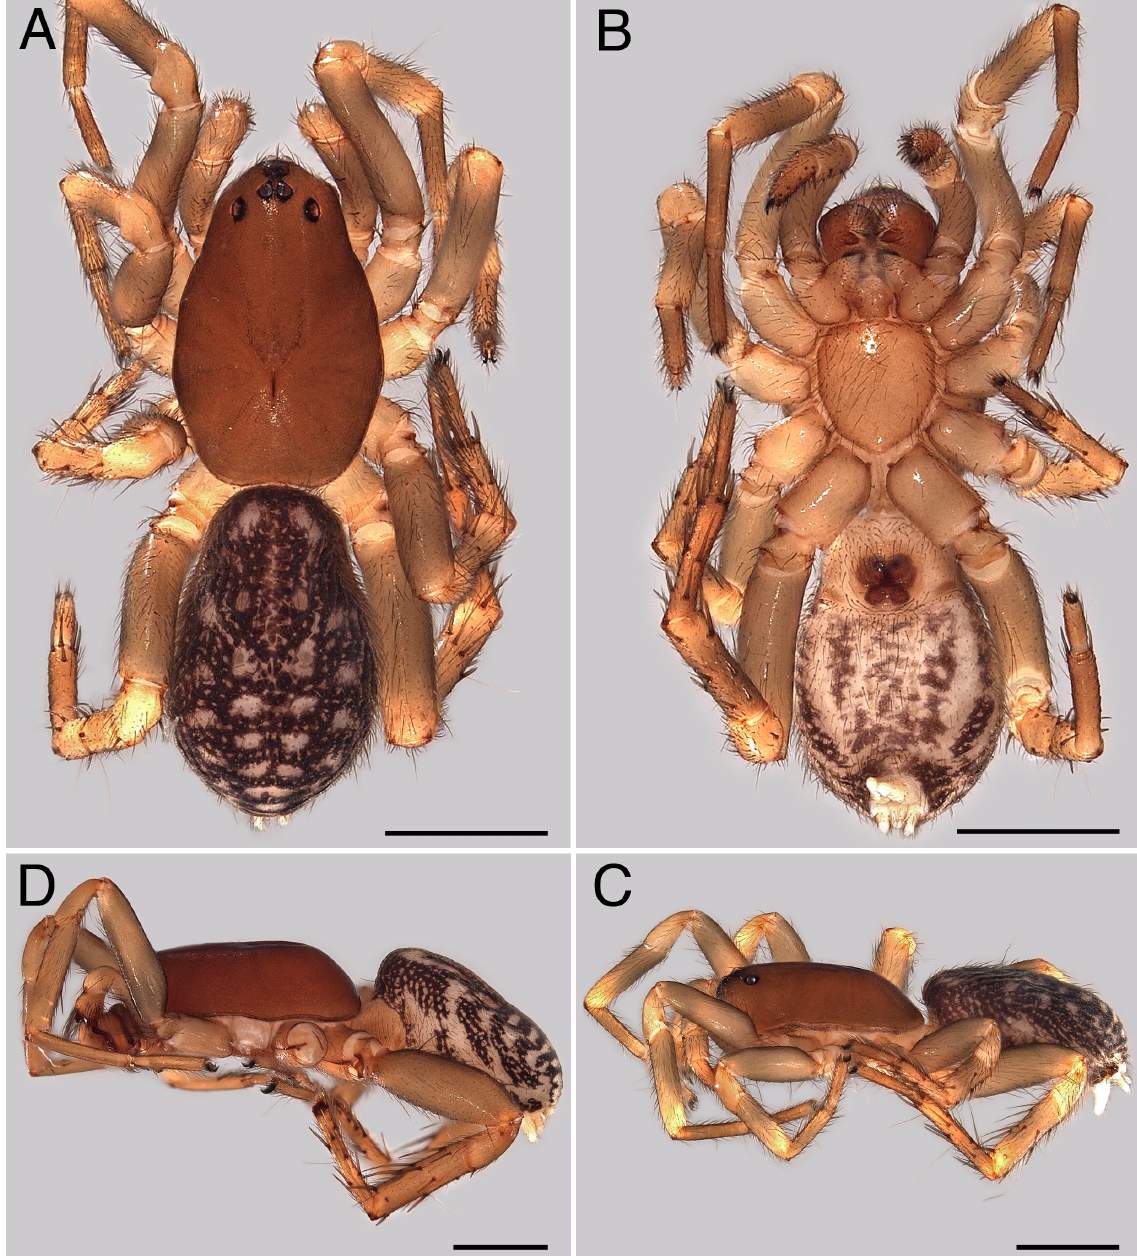
Fig. 2. Ballomma erasmus gen. et sp. nov. A–C . Paratype, ♀. D . Holotype, ♂. A . Habitus, dorsal view. B . As preceding, ventral view. C . As preceding, lateral view. D . Habitus, lateral view. Scale bars: 1